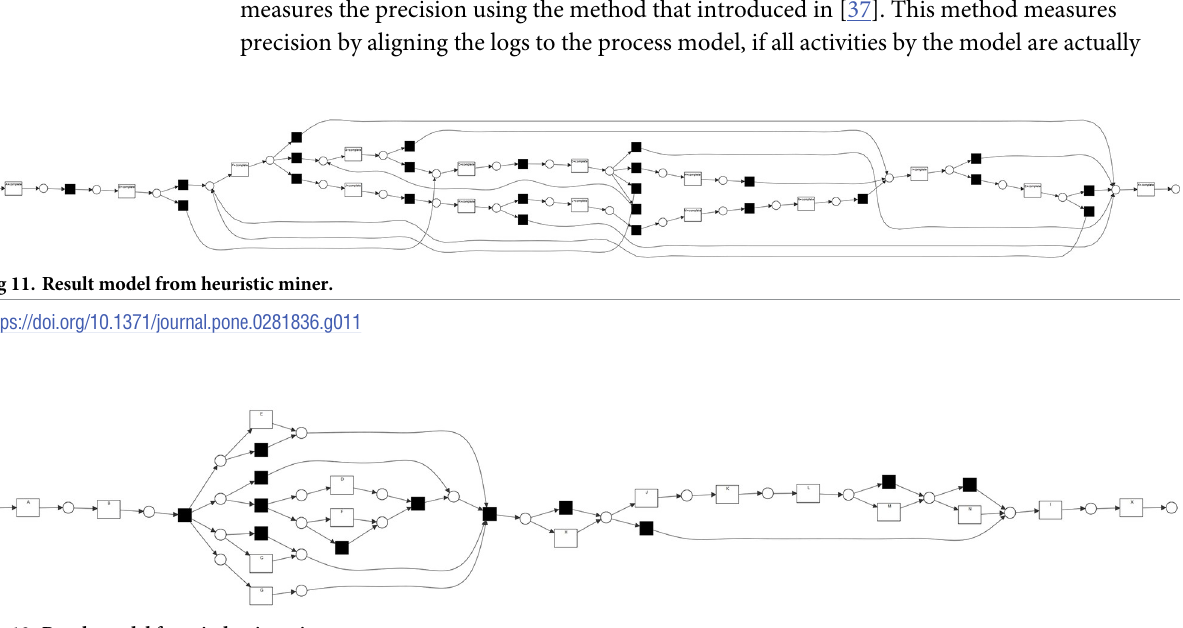
Fig 12. Result model from inductive